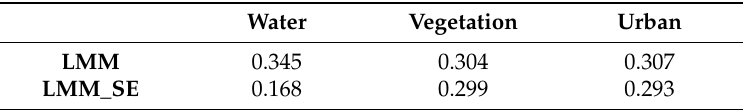
Table 1. The proportion root mean squared error (RMSE) comparison. Water